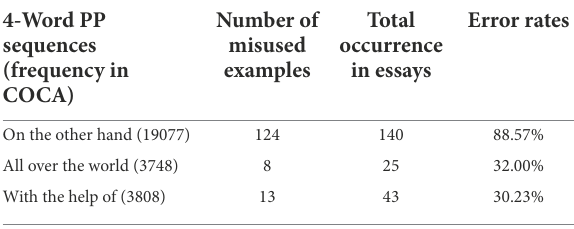
TABLE 10 Misused 4-Word PP sequences characterized by high frequency in COCA. 4-Word PP